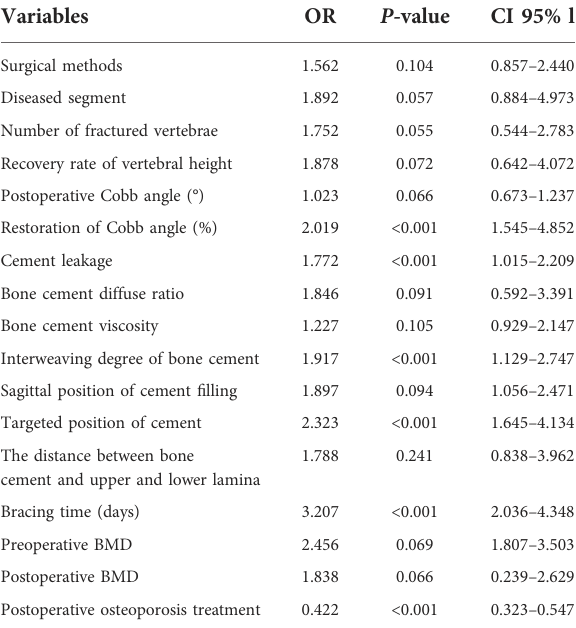
TABLE 2 Multivariate logistic regression analysis of postoperative bone cement